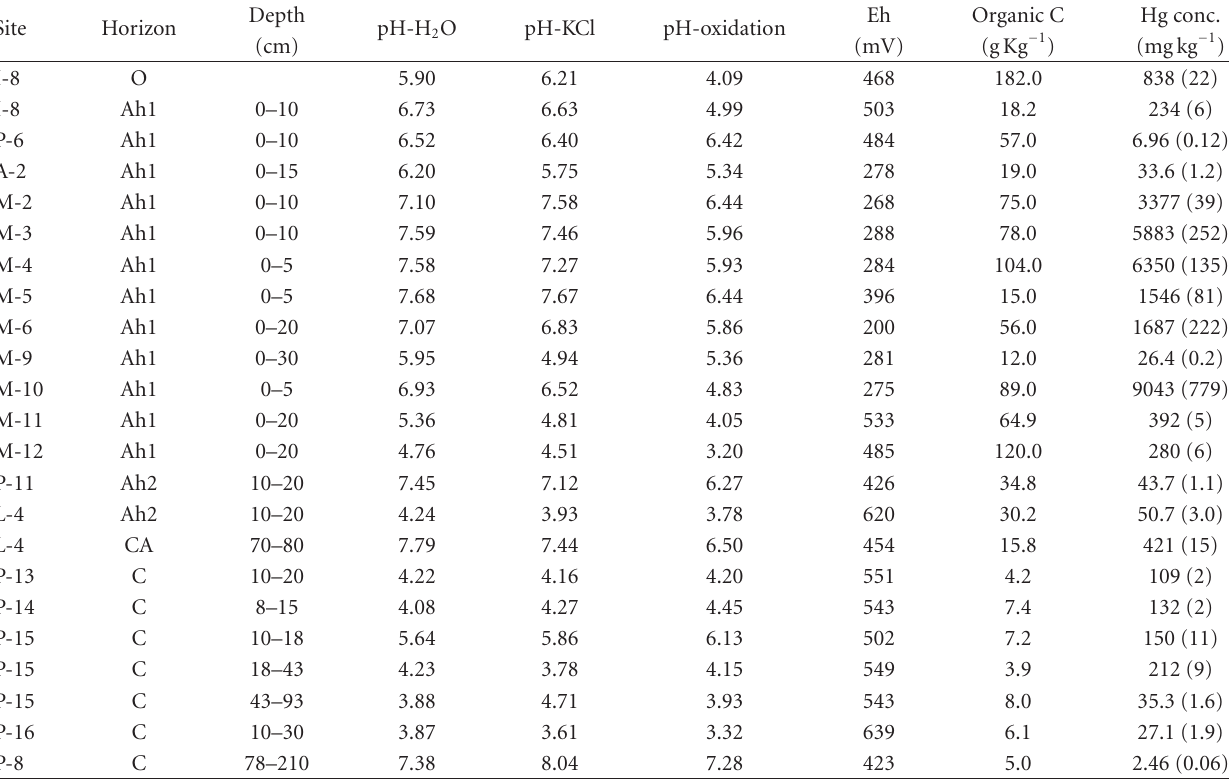
Table 1: Values of pH in water, KCl, and H 2 O 2 (pH of oxidation), Eh of selected soil samples, organic C content, and Hg concentration of selected soil samples. Standard errors of Hg concentrations are indicated in parentheses ( n =